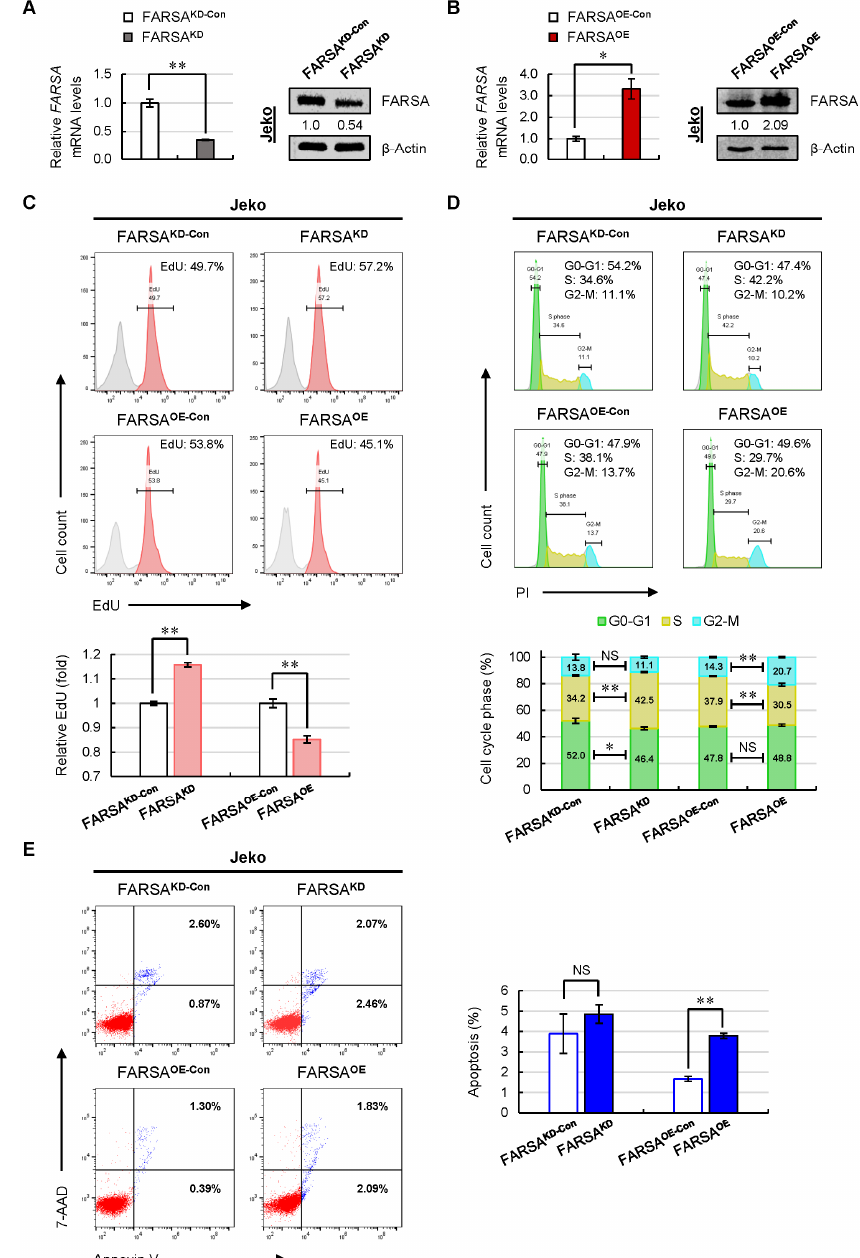
Figure 2. Knockdown of FARSA in Jeko cells accelerates cell proliferation and cell cycle. The knockdown ( A ) and overexpressed efficiency ( B ) of FARSA in Jeko cells were validated using qRT-PCR ( left ) and immunoblotting ( right ), respectively. Each value from qRT-PCR was normalized to ACTB and is presented as the mean ± SD. β -Actin was used as a loading control for immunoblots with the normalized values (FARSA/ β -Actin) indicated under each lane. ( C ) Representative intracellular pulse staining of EdU in FARSA KD and FARSA OE Jeko cells ( upper ). The % population of EdU positive cells was normalized to the control cells ( lower ), and the data are shown as the mean ± SD from three independent experiments. ( D ) Representative cell cycle distribution of FARSA KD and FARSA OE Jeko cells staining with PI ( upper ). The % population of cells in each phase is shown as the mean ± SD from three independent experiments ( lower ). ( E ) Representative cell apoptosis in FARSA KD and FARSA OE Jeko cells staining with Annexin V/7-AAD ( left ). The % population of apoptotic cells in each group is shown as the mean ± SD from three independent experiments ( right ). NS, not significant; * p < 0.05; ** p < 0.01 (vs. control